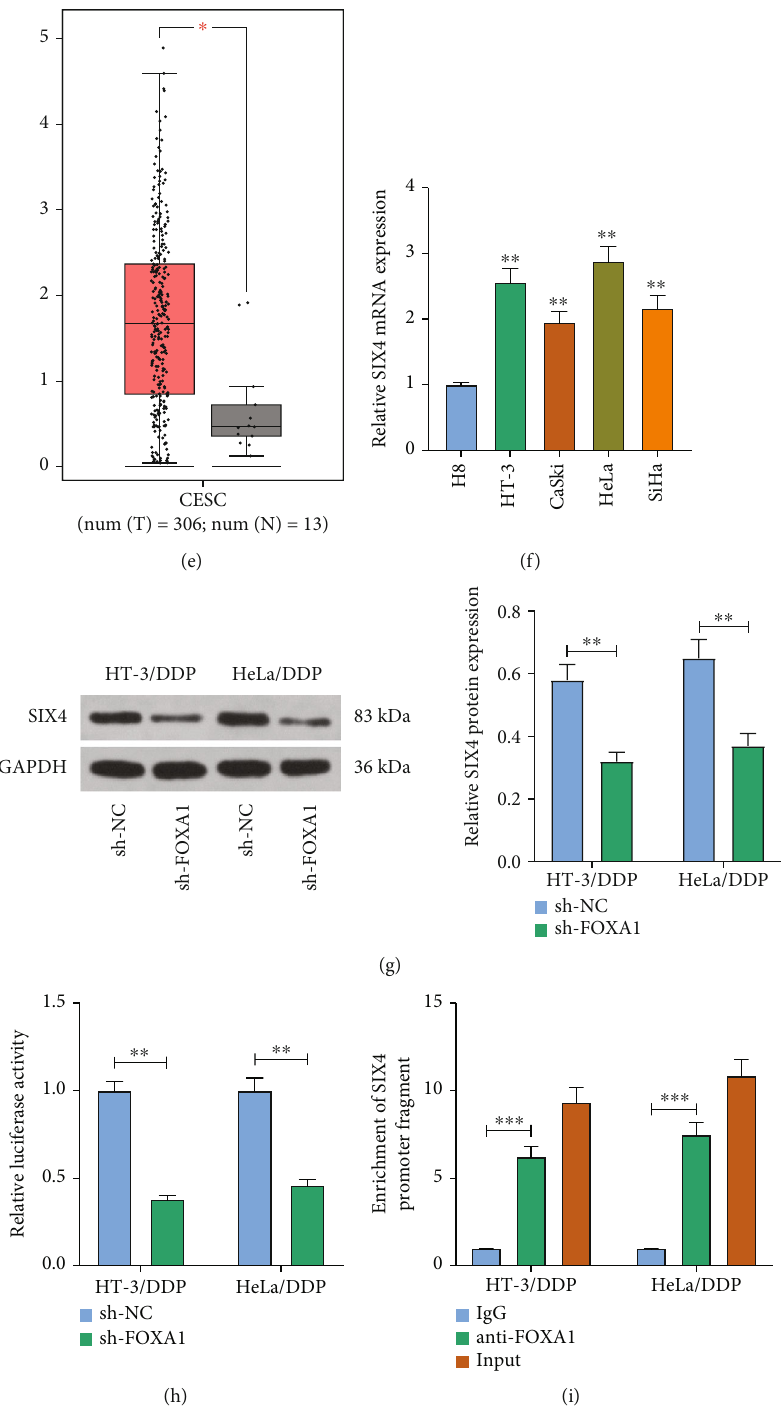
Figure 3: Knockdown of FOXA1 inhibits SIX4 expression in CC cells. (a) SIX4 was predicted to be a downstream gene of FOXA1 using hTFtarget database. (b) High expression of SIX4 in CESC in TCGA database. (c) Conserved binding sites for FOXA1. (d) Potential binding sites of SIX4 promoter to FOXA1. (e) SIX4 expression in TCGA-CESC database. (f) Detection of SIX4 mRNA expression in normal cervical epithelial cells H8 and CC cell lines (HT-3, CaSki, HeLa, and SiHa) by RT-qPCR. (g) Detection of SIX4 protein expression in drug-resistant cells after knockdown of FOXA1 measured using Western blot. (h) The e ff ect of low expression of FOXA1 on the Promoter luciferase activity of SIX4 measured using dual-luciferase assay. (i) The ability of anti-FOXA1 to enrich SIX4 promoter sequence examined using ChIP assay. Data among multiple groups were analyzed by one-way or two-way ANOVA followed by Tukey ’ s post hoc test ( ∗ p < 0 : 05 , ∗∗ p < 0 : 01 , ∗∗∗ p < 0 : 001 ). The cell experiment was independently repeated three